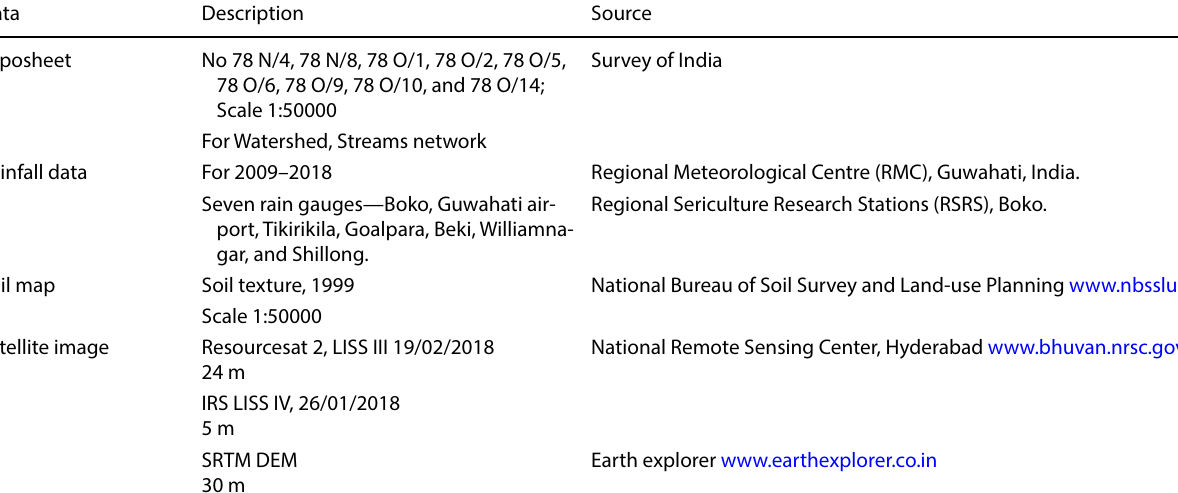
Table 1 Detailed of the database used in the study